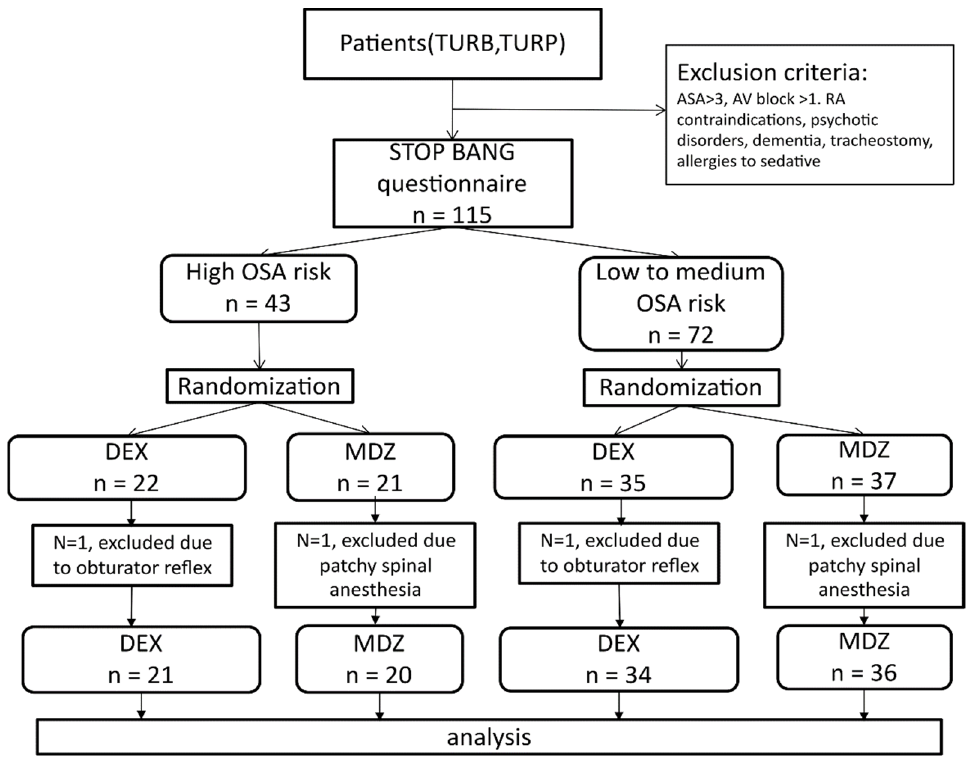
Figure 1. Patient flowchart. OSA—obstructive sleep apnea; TURB—transurethral resection of bladder; TURP—transurethral resection of prostate; RA—regional anesthesia; ASA—American Society of Anesthesiologist; DEX—dexmedetomidine; MDZ—midazolam.